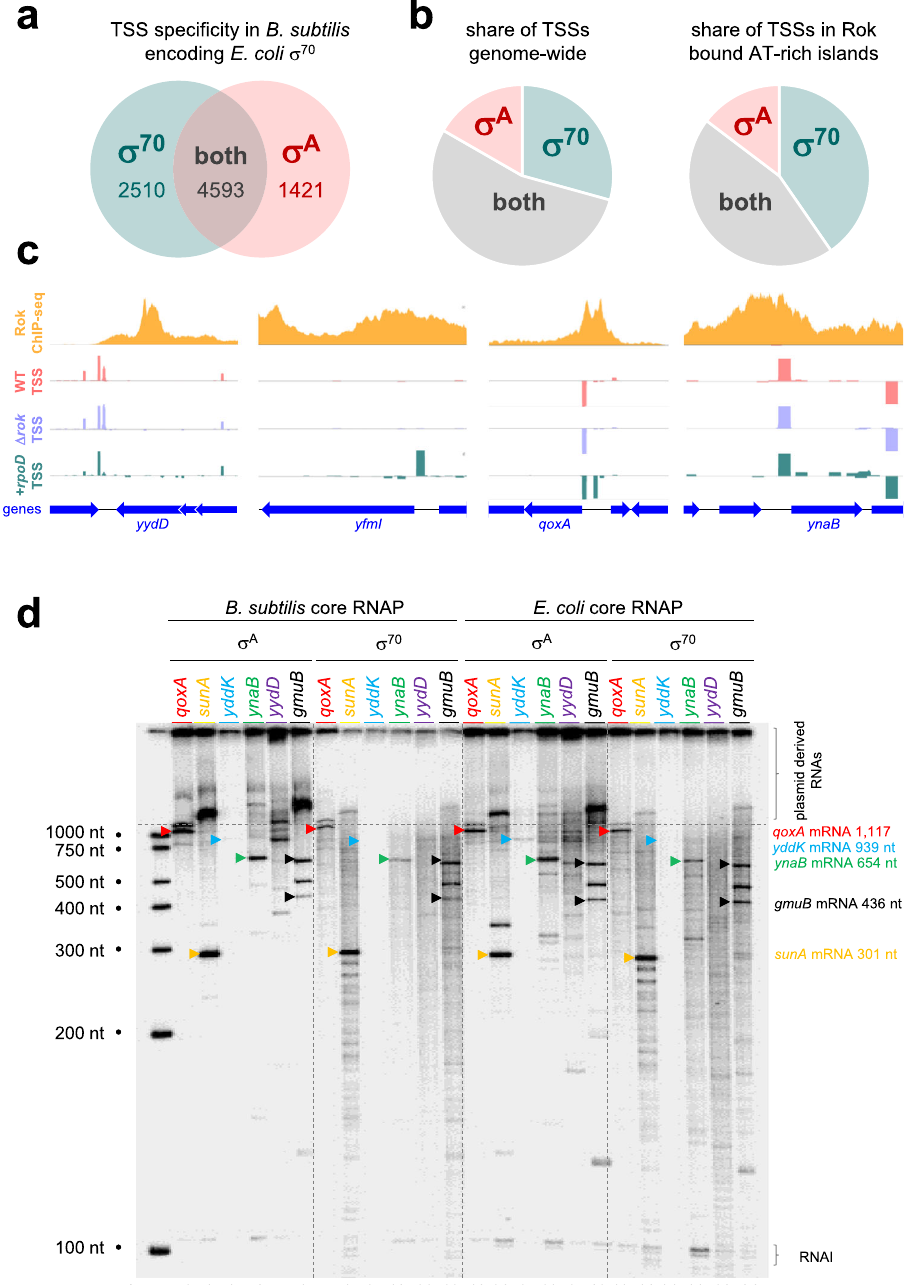
Fig. 4 Expression of the E. coli RNA polymerase σ 70 subunit is suf fi cient for promiscuous transcription in B. subtilis . a The Venn diagram shows the distribution of TSSs identi fi ed in B. subtilis by cappable-seq in different genetic backgrounds. The teal area represents TSSs only detected upon expression of E. coli rpoD whilst the pink section represents TSSs only identi fi ed in the absence of rpoD expression. The overlap identi fi es those TSSs detected both with and without rpoD expression. b The pie charts show the distribution of B. subtilis TSSs identi fi ed in different genetic backgrounds and in different parts of the genome. The number of TSSs dependent on E. coli σ 70 expression is higher in horizontally acquired AT-rich sections of DNA targeted by Rok. Conversely, the number of σ A dependent TSSs is lower in these regions. c Examples of E. coli σ 70 dependent transcription initiation within horizontally acquired B. subtilis genes. Data from ChIP-seq experiments for Rok occupancy 35 are shown by the orange graph. Transcription start sites (TSSs) were identi fi ed by cappable-seq for wild-type (pink graph), Δ rok (mauve graph) and B. subtilis cells carrying the σ 70 encoding rpoD gene (teal graph). Sequence reads mapping to the top and bottom DNA strands are shown above and below the central horizontal line in each plot. Genes are indicated with block blue arrows. d Results of in vitro transcription assays using AT-rich horizontally acquired genes targeted by Rok cloned in plasmid pSR as the DNA template. Transcription reactions were done using core RNA polymerase, from either B. subtilis or E. coli , in conjunction with either σ Α or σ 70 (0.5 μ M fi nal holoenzyme concentration). For each DNA template, bands corresponding to full-length mRNAs are indicated by coloured arrowheads. The experiment was done twice with similar